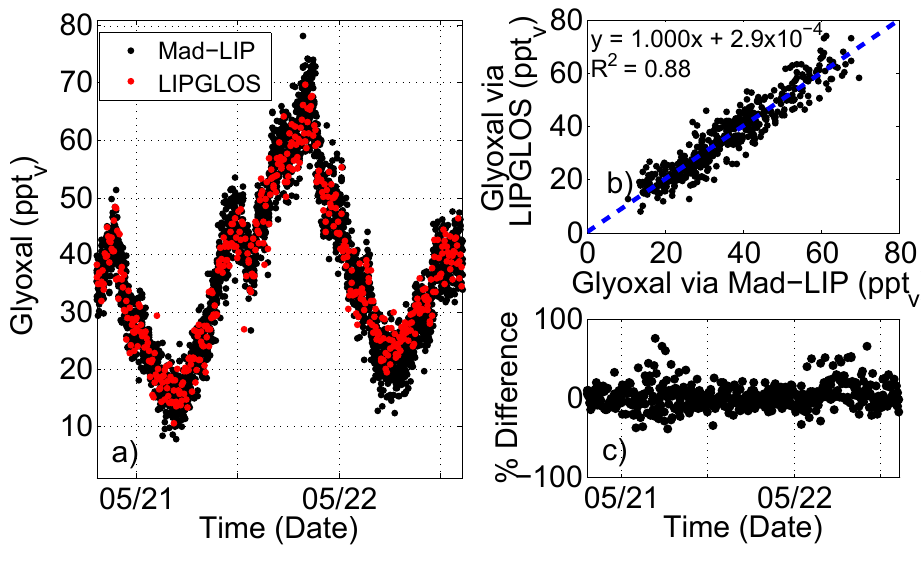
Fig. 7. (a) Glyoxal concentration time series from both Mad-LIP (40s integration) and the LIPGLOS method (80s integration). During early morning of the 21st when the concentrations are at their lowest, the standard deviation of the LIPGLOS and gated photon integration data is 4.0pptv (extrapolated) and 2.9pptv in 40s, respectively. (b) Correlation of measurements coincident within 5 min. (c) Difference between the LIPGLOS method and Mad-LIP normalized to Mad-LIP measured glyoxal. During the day time hours, the standard deviation of the difference is 8%. During the night, the deviation increases when the noise of the measurement allows values close to zero in the normalization value (glyoxal determined by